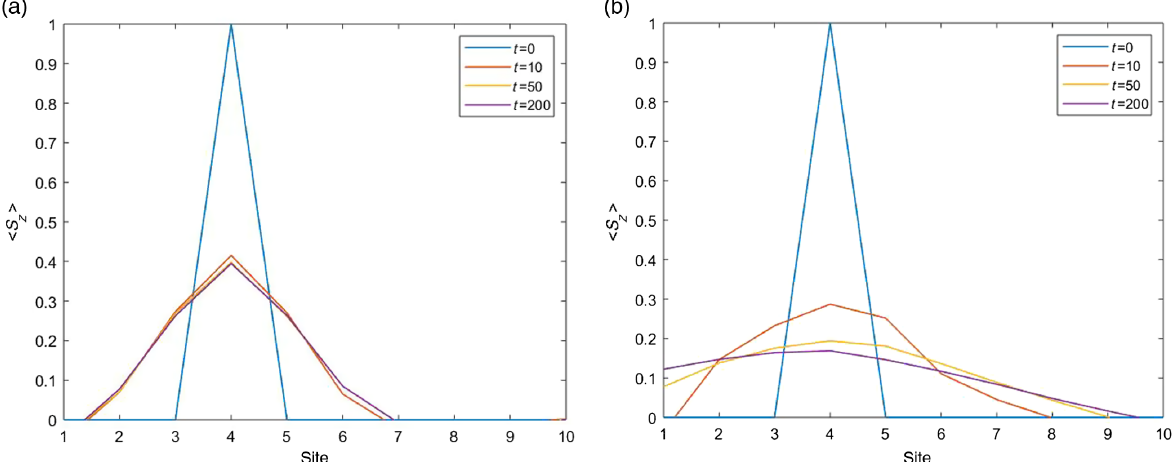
FIG. 2. S z expectation values in the spin-1 L ¼ 10 chain, initialized with a single fracton on site 4. Expectation values are renormalized so that h S z ð t ¼ 0 Þi ¼ 1 [without renormalization, we would have h S z ð t ¼ 0 Þi ¼ 2 = 3 ]. (a) Three-site gates, (b) Four-site